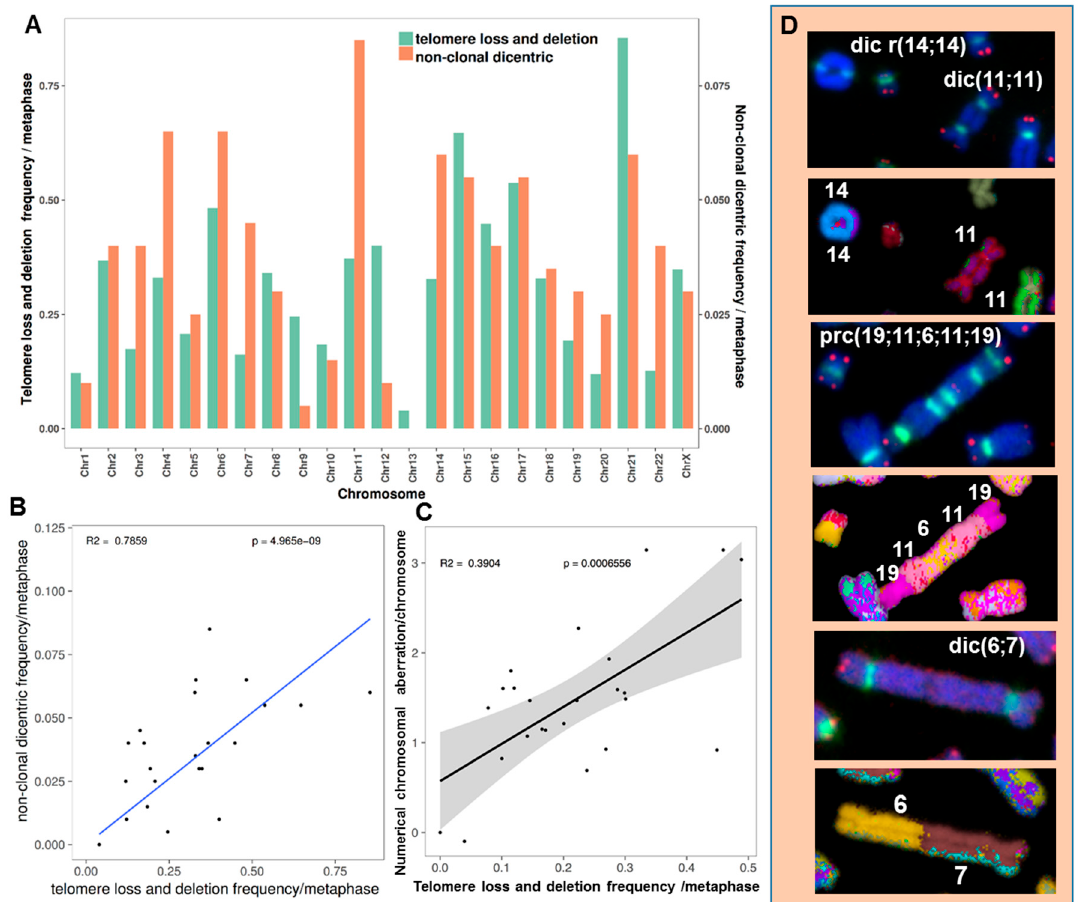
Figure 14. Chromosomal instability in HL cells correlates with telomere dysfunction. ( A ) The distribution of individual chromosomes involved in non-clonal dicentric chromosome formation correlates with the profile of individual chromosomes with telomere dysfunction (loss and deletion). The diagram represents all HL metaphases analyzed. ( B ) Regression analysis between the frequency of telomere loss among the different chromosomes and their involvement in non-clonal dicentric chromosomes. The diagram represents all HL metaphases analyzed. ( C ) Regression analysis between the frequency of telomere loss among the different chromosomes and their involvement in numerical chromosomal aberrations. ( D ) Partial metaphases showing non-clonal dicentric and ring chromosomes. Interstitial telomeres were detected at the breakpoint, suggesting that dicentric chromosome formation is related to telomere dysfunction (63× magnification).